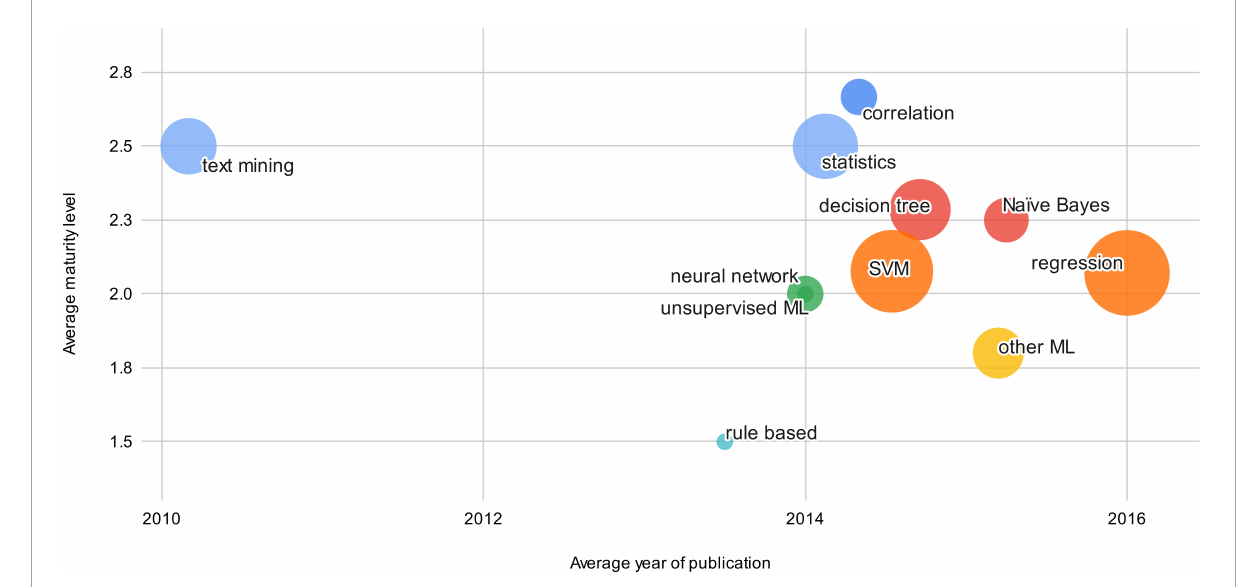
FIGURE7 Decision technology concepts.